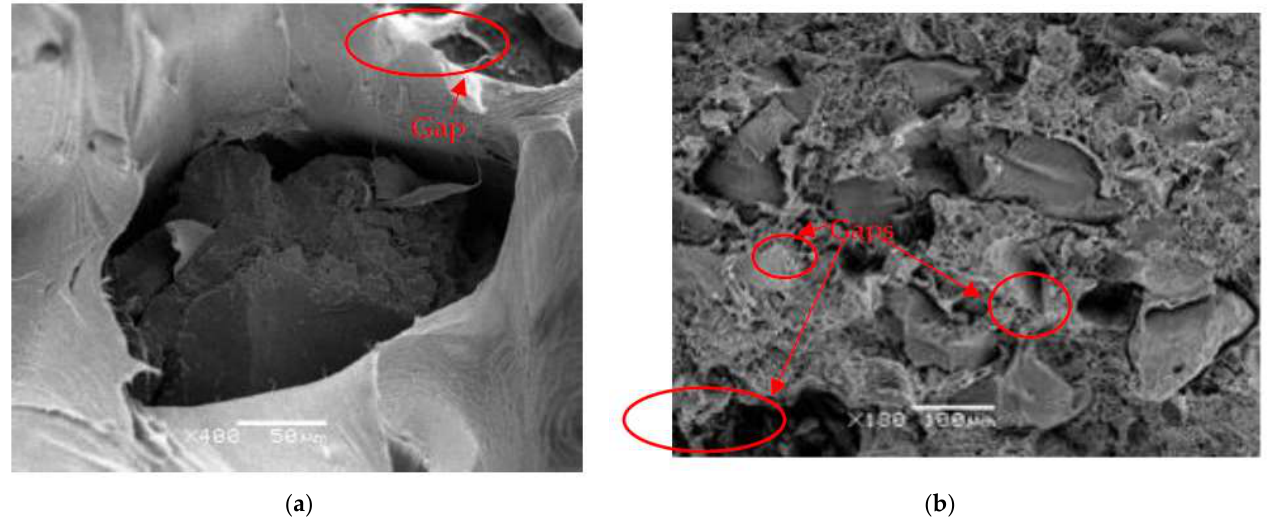
Figure 2. Scanning electron microscopy (SEM) micrographs of ( a ) LDPE/20%GTR compounds at 400 magnification and ( b ) HDPE/20%GTR-compounds at 180 magnifications.